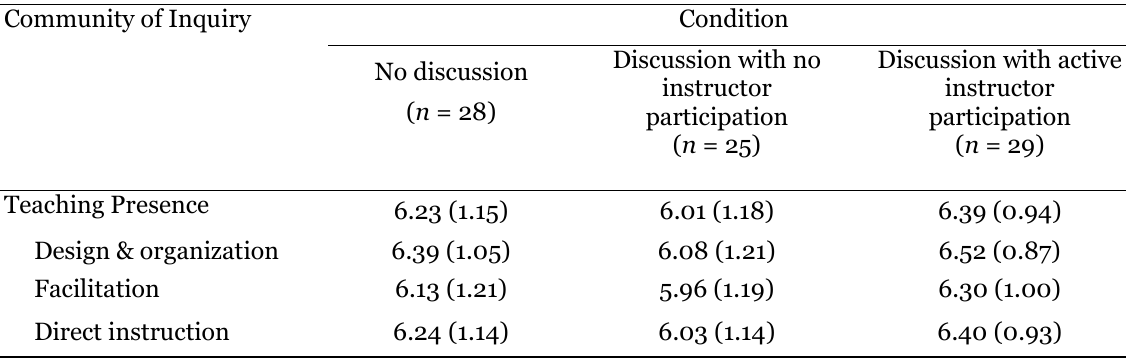
Table 1 Mean and Standard Deviation of CoI by Conditions Community of